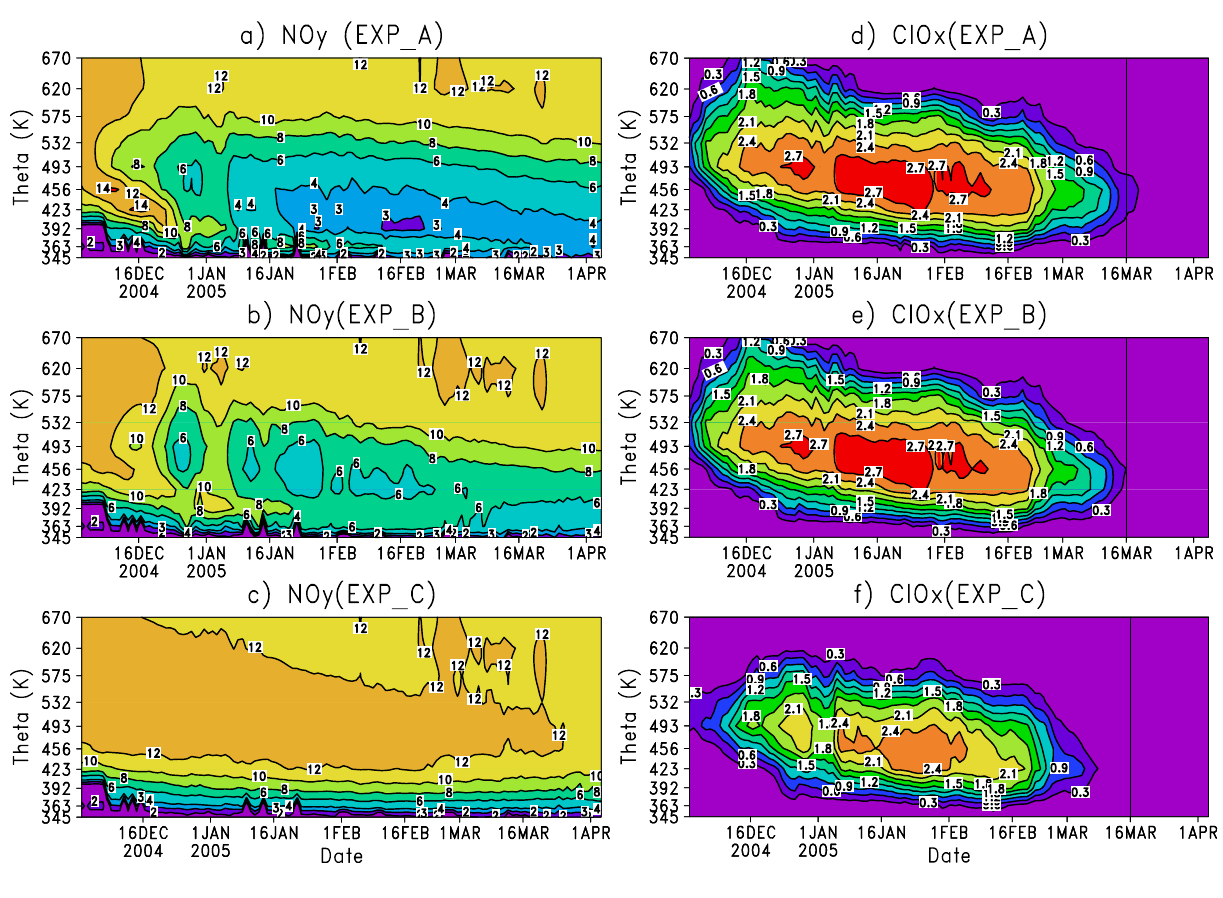
Fig. 5. Vortex-averaged NO y and ClO x (ppbv) as a function of time and potential temperature for SLIMCAT simulations using the equi- librium (EXP A) and DLAPSE (EXP B) PSC schemes and the simulation without denitrification (EXP C) for Arctic winter 2004/2005.